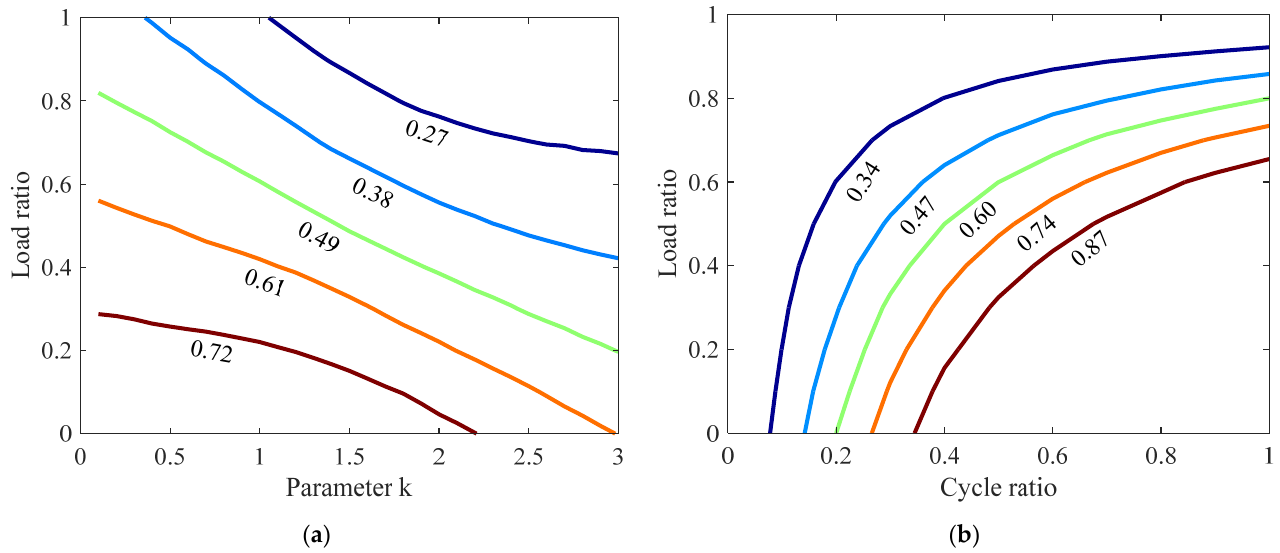
Figure 7. Failure probability of this composite bridge beam. ( a ) Cycle ratio = 0.3. ( b ) Parameter k = 1.5.